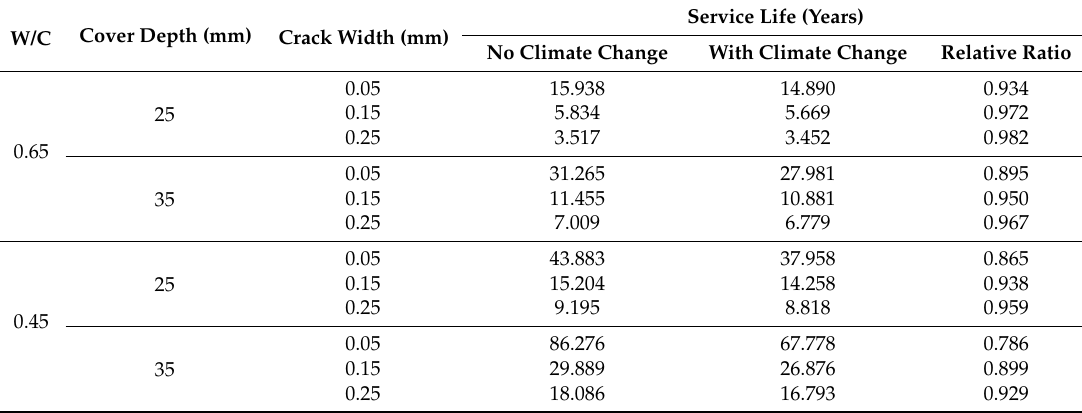
Table 5. Service life of cracked concrete-RCP 4.5, time slice